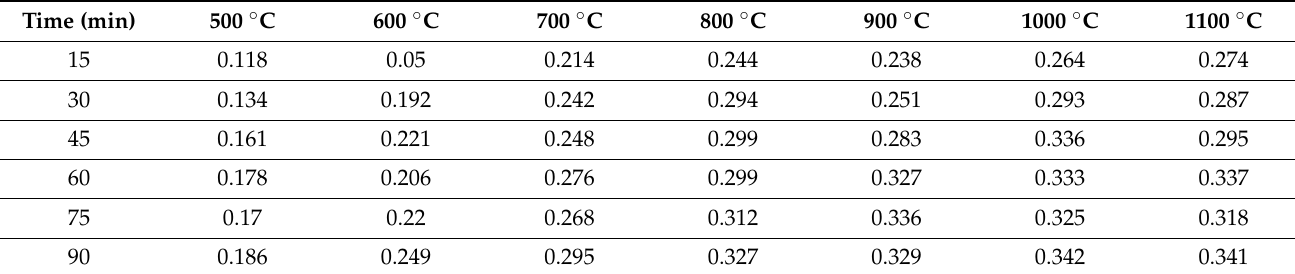
Table 4. Increased mass (g) during oxidation between 500 °C and 1100 °C.